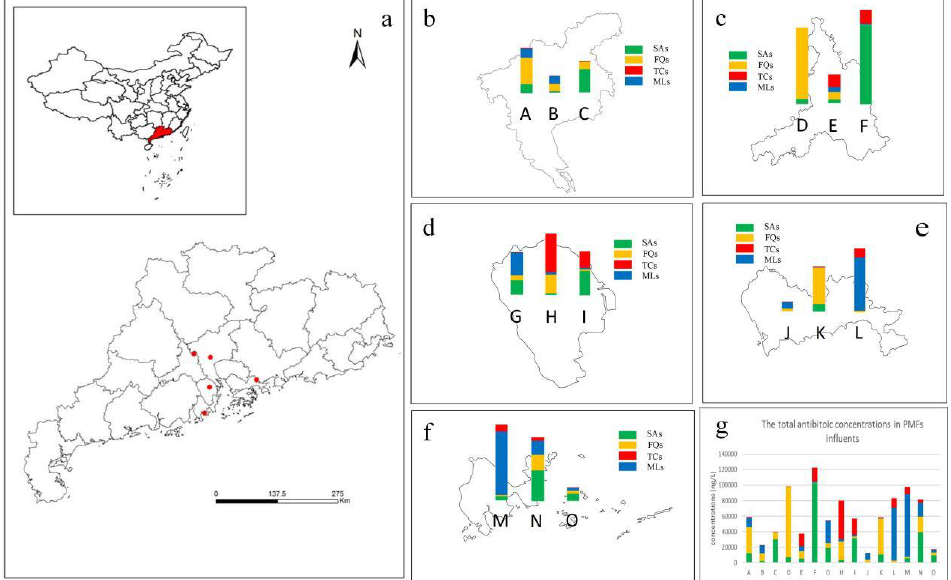
Figure 1. Concentration and distribution of antibiotics in influents samples from 12 pharmaceutical plants of China. ( a ): map of sampling locations. ( b ): the concentration of antibiotics in influent of Guangzhou pharmaceutical plants. ( c ): the concentration of antibiotics in influent of Foshan pharmaceutical plants. ( d ): the concentration of antibiotics in influent of Zhongshan pharmaceutical plants. ( e ): the concentration of antibiotics in influent of Shenzhen pharmaceutical plants. ( f ): the concentration of antibiotics in influent of Zhuhai pharmaceutical plants. ( g ): the total antibiotics concentration in pharmaceutical plants influent. (Abbreviations: SAs: sulfonamides; FQs: fluoroquinolones; MLs: macrolides; and TCs: tetracyclines) A–O: pharmaceutical plants A–O respectively.